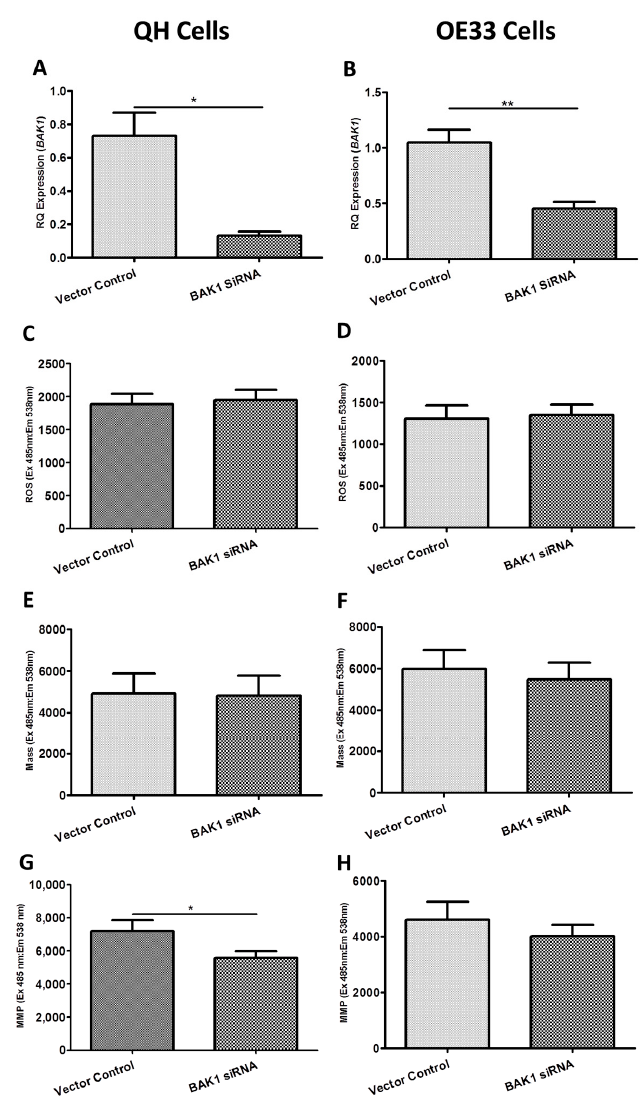
Figure 3. Functional effect of BAK1 siRNA knockdown on reactive oxygen species (ROS) production, mitochondrial mass and mitochondrial membrane potential (MMP) in the QH (Barrett’s) and OE33 (adenocarcinoma) cell lines in vitro. ( A ) BAK1 gene expression was significantly knocked down (81.9%) in the BAK1 -siRNA treated QH cell line ( p = 0.0191). ( B ) BAK1 gene expression was significantly knocked down (56.9%) in the BAK1 -siRNA treated OE33 cell line ( p = 0.0030). ( C ) BAK1 knockdown had no significant effect on ROS production in the QH ( p > 0.05) or ( D ) OE33 cell lines ( p = 0.5723). ( E ) BAK1 knockdown had no significant effect on mitochondrial mass in QH ( p = 0.8269) or ( F ) OE33 cell lines ( p = 0.1114). ( G ) BAK1 knockdown significantly decreased MMP in the QH cell line ( p = 0.0454) ( H ) but had no significant effect on MMP in the OE33 cell line ( p = 0.3080). Paired t -tests assessed statistical differences between vector control and siRNA treated QH ( n = 4) and OE33 ( n = 4) cells. Bars denote mean ± SEM. * p < 0.05 and ** p < 0.01.